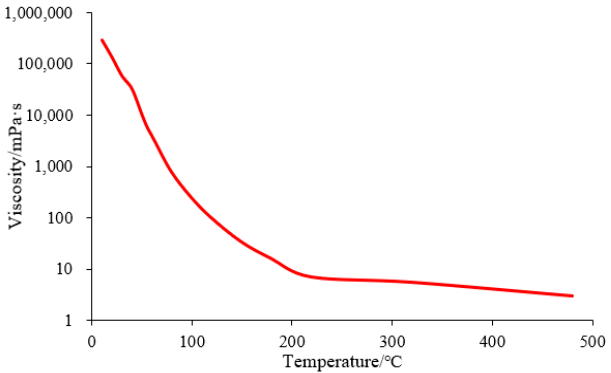
Figure 3. Oil viscosity versus temperature in the simulation model.